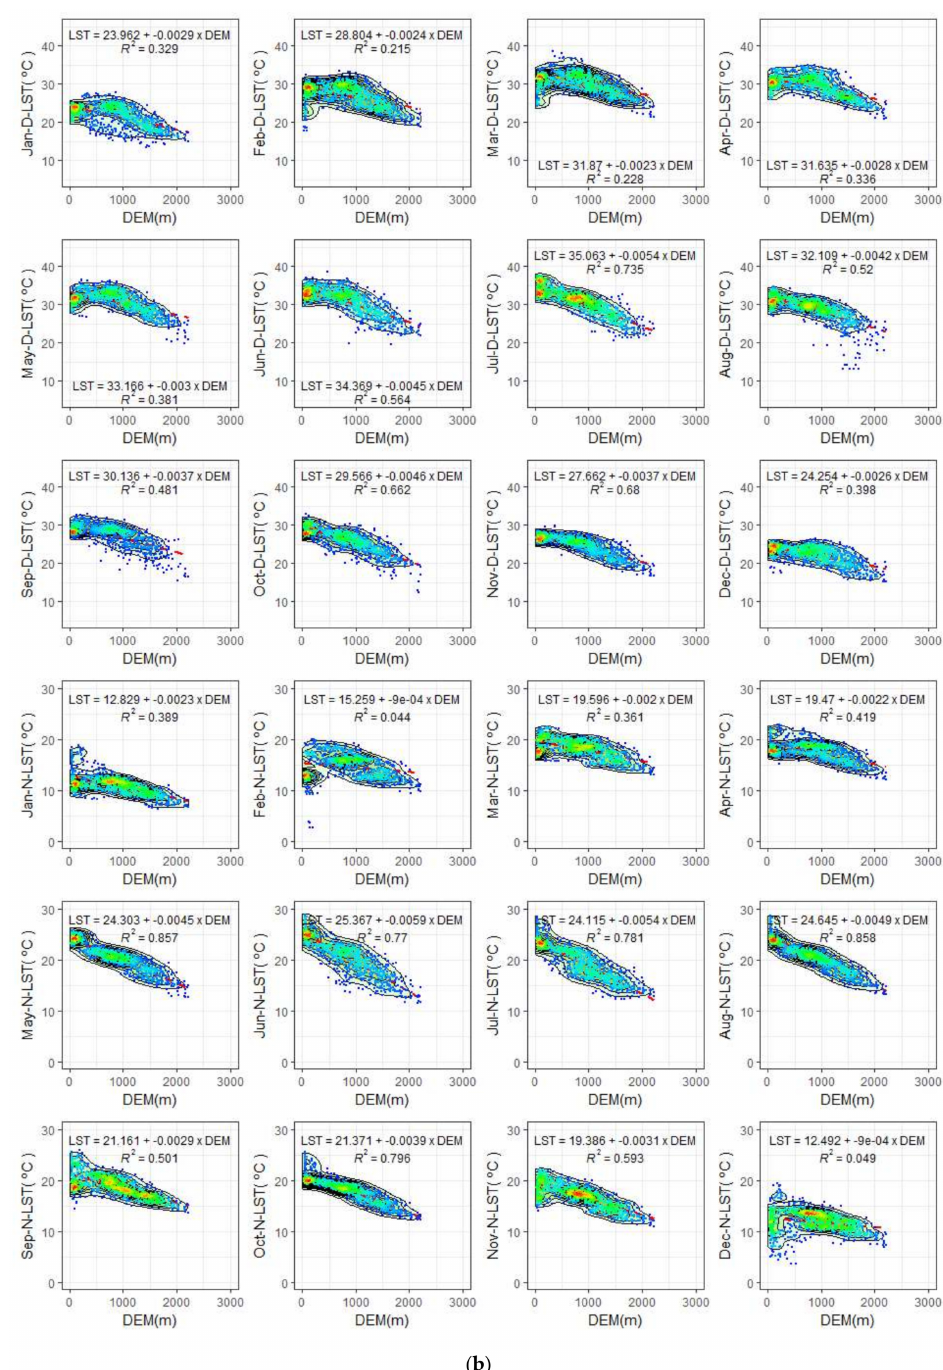
Figure 7. ( a ) Scatter plots showing the relationship between the average monthly LST (daytime and nighttime) and elevation of Lane 1 in 2015. ( b ) Scatter plots showing the relationship between the average monthly LST (daytime and nighttime) and elevation of Lane 2 in 2015. The color ramp from blue to red expresses the point density from low to